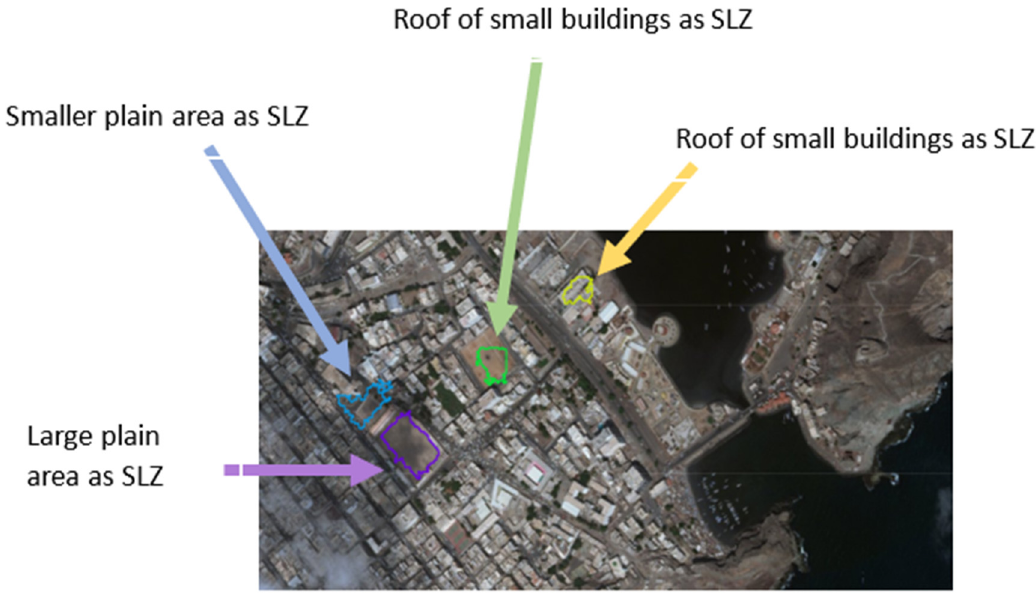
Figure 7. Multiple Safe Landing Zones (SLZ) of Scene 1 projected on an aerial map.